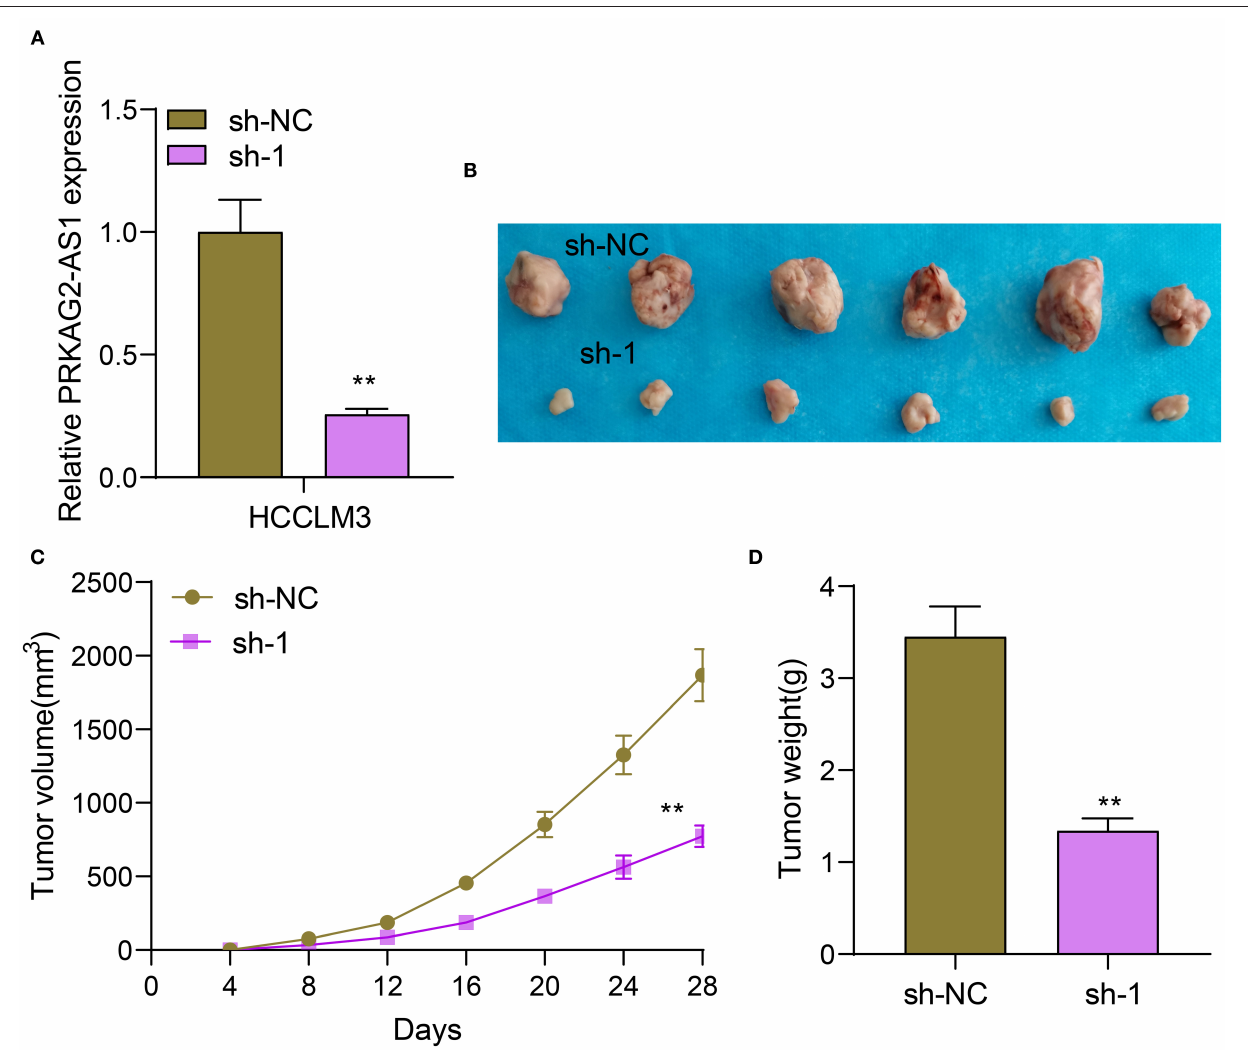
FIGURE 3 | Silencing PRKAG2-AS1 suppresses tumor growth. (A) RT-qPCR for the expression of PRKAG2-AS1 in HCCLM3 cells transfected with sh-NC and sh-1 targeting PRKAG2-AS1. (B) Tumor images from nude mice inoculated with HCCLM3 cells transfected with sh-NC and sh-1. (C) The tumor growth curves. (D) Measurement of the tumor weights. ** p <